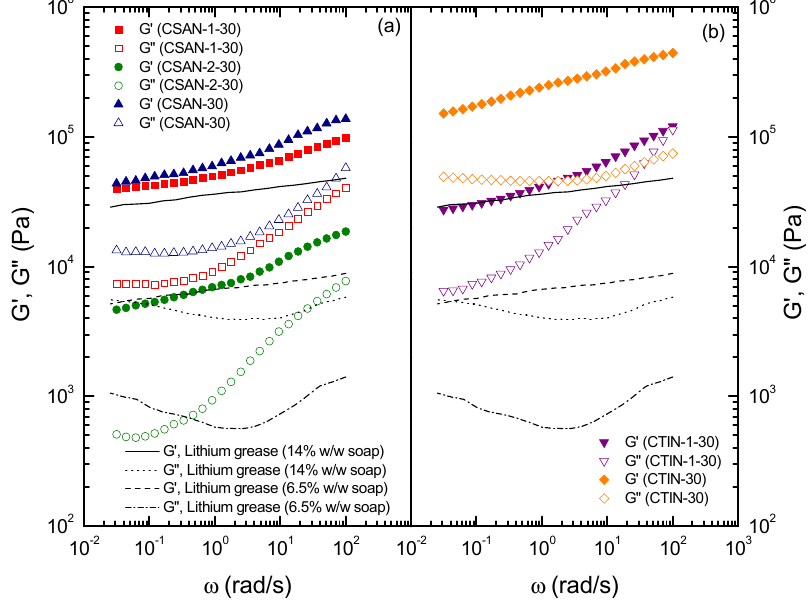
Figure 8. Frequency dependence of the storage [G'] and loss [G''] moduli for NCO–functionalized and non–functionalized ( a ) chitosan and ( b ) chitin gel-like dispersions in castor oil (G': full symbols, G'': open symbols; ageing time: 1 month). Solid and dashed lines correspond to conventional lithium greases containing 14% and 6.5% soap concentration (from reference